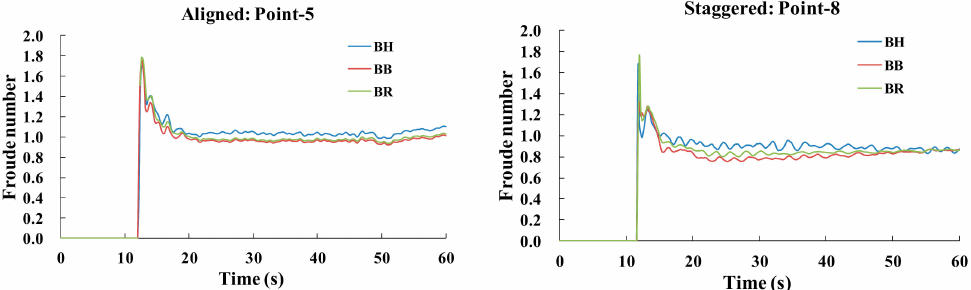
Figure 14. Froude number at gauges P5 and P8 in the aligned and staggered cases,